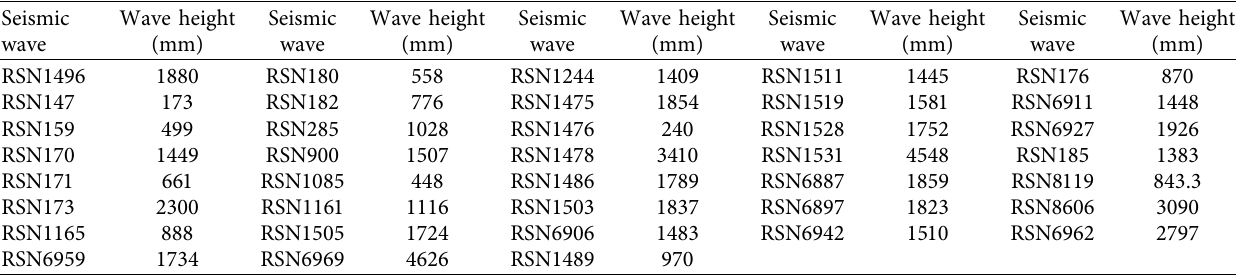
Table 3: Spectrum parameters and excitation wave heights of near-fault ground motions.